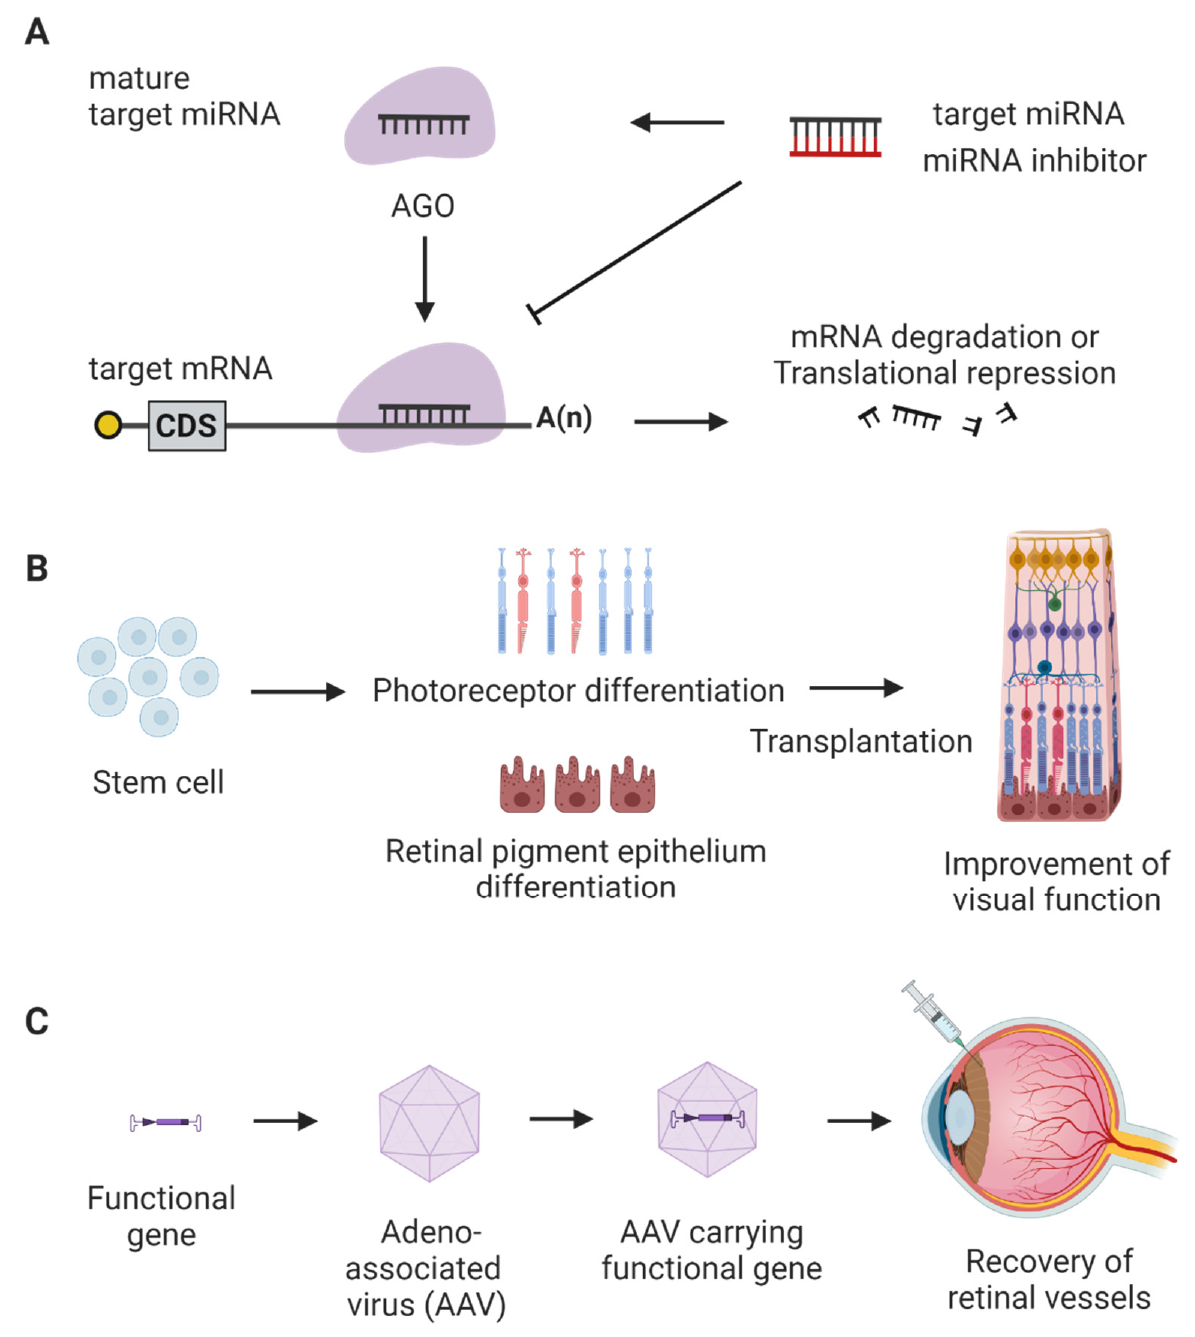
Figure 2. Potential therapies for retinopathy of prematurity (ROP). Examples of non-coding RNA therapy, cell therapy, or gene therapy are shown. ( A ) microRNA inhibitor can be used to suppress target microRNA. In a canonical pathway of microRNA biogenesis, single-stranded mature microRNA is loaded into ARGONAUTE (AGO) protein. Then AGO-microRNA complex binds to target messenger RNA inhibiting its action. When microRNA inhibitor is introduced, it binds to its target microRNA specifically and prevents messenger RNA degradation or translational attenuation. ( B ) Stem cells can be differentiated to photoreceptors or retinal pigment epithelium. These differentiated cells can be transplanted to the retina and visual function can be improved. ( C ) Functional gene having anti-angiogenic effects can be incorporated in an adeno-associated virus vector (AAV). AAV carry- ing anti-angiogenic genes may be directly administered to the retina using intravitreal injection to treat